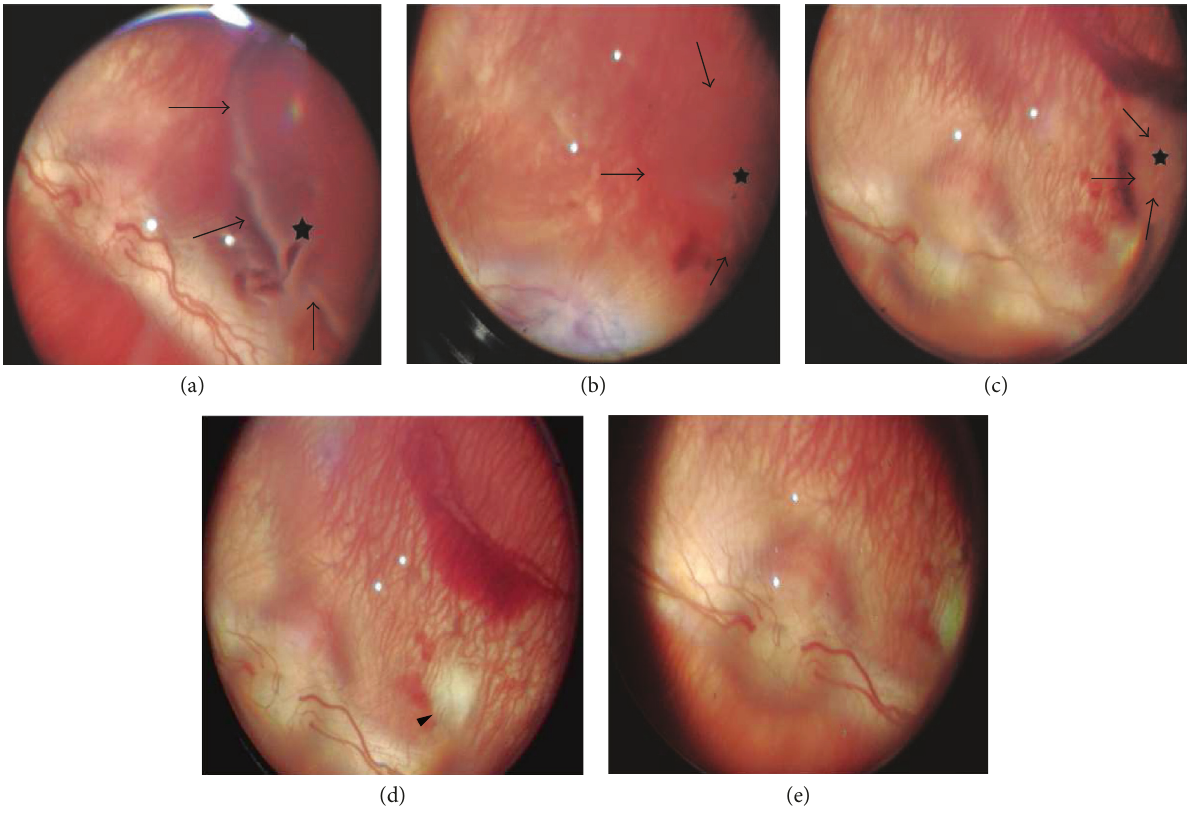
Figure 3: Representative fundus follow-up of retinal detachment in a single experimental eye. (a) 0, (b) 3, (c) 7, (d) 14, and (e) 21 days postdetachment. Retinal detachment (arrows), tear (asterisk), and local scar (arrowhead) are